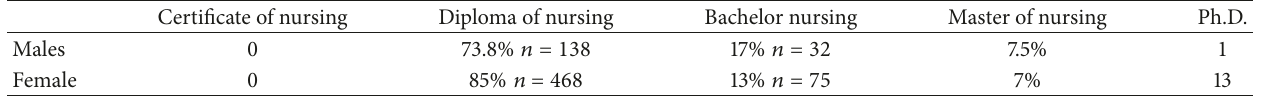
Table 1: Respondents’ highest qualification.